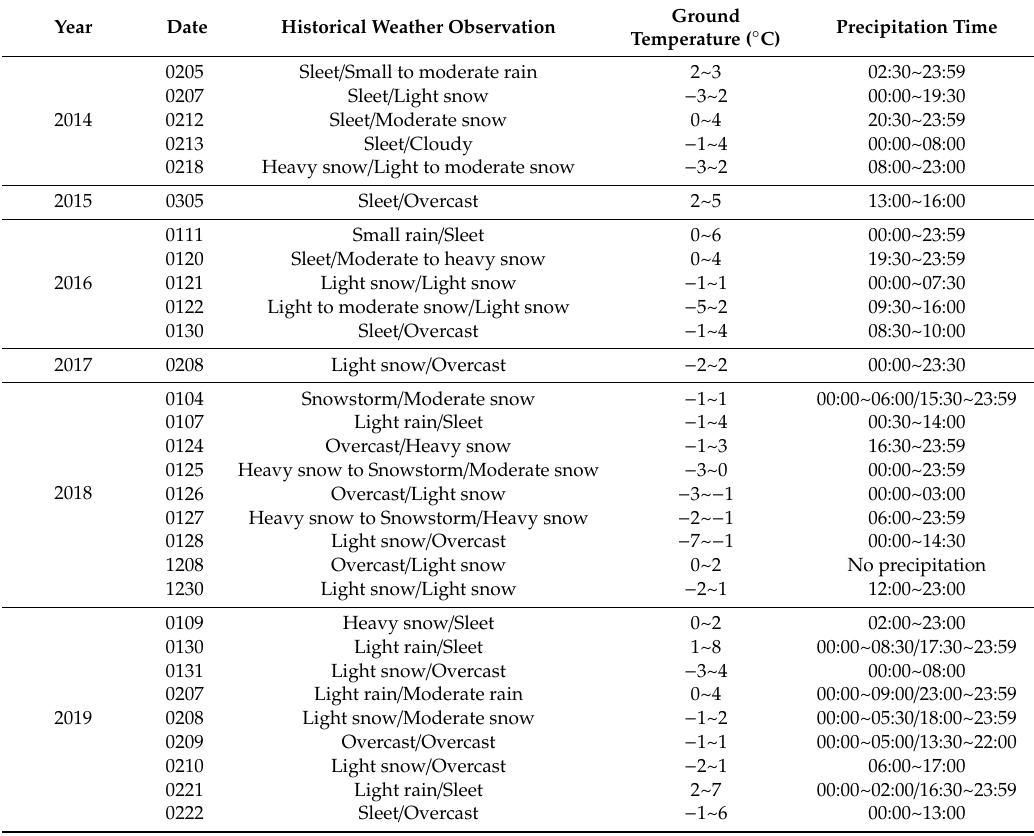
Compared with the data recorded by the PARSIVEL disdrometer, the weather observation of the date corresponding to the shadow part in the table was incorrect. Light snow was observed for